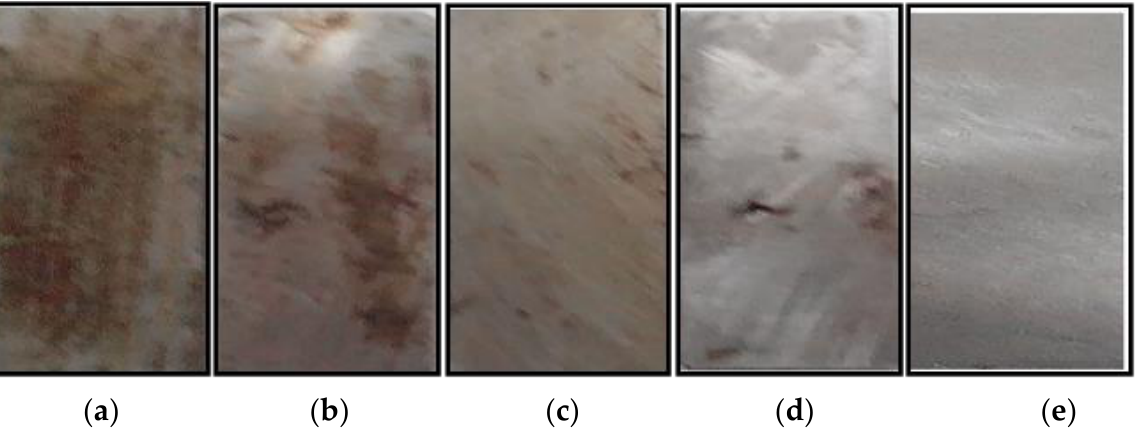
Figure 3. Optical images of cast iron coupons after 7 days of exposure to 3.5 wt.% NaCl ( a ) uncoated, ( b ) coated with PVA, ( c ) coated with PVA/PANI, ( d ) coated with PVA/GO-COOH, ( e ) coated with PVA/PANI/GO-COOH.